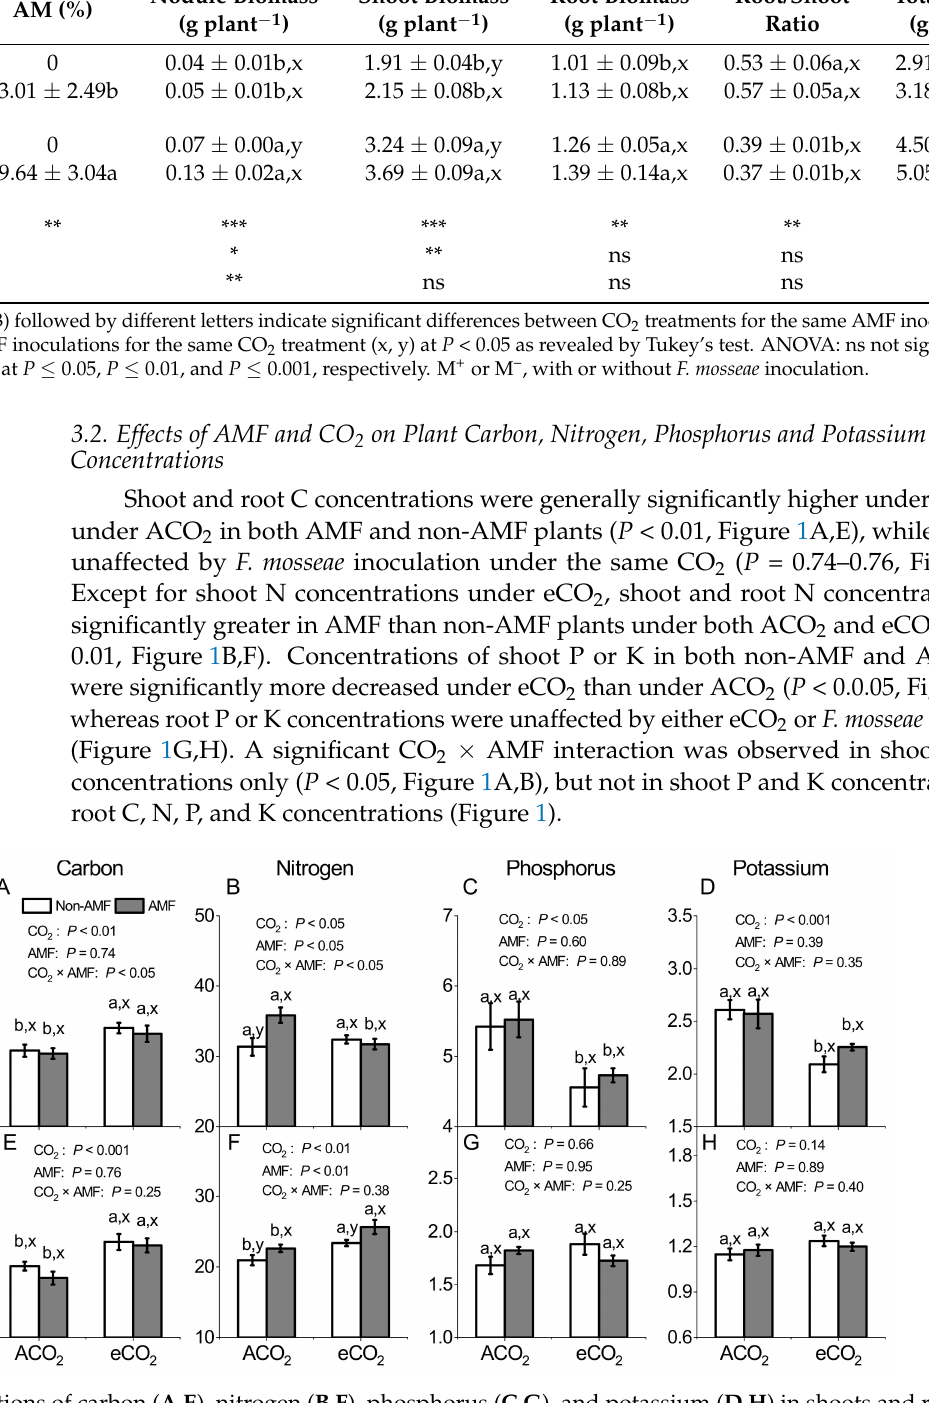
Figure 1. Concentrations of carbon ( A , E ), nitrogen ( B , F ), phosphorus ( C , G ), and potassium ( D , H ) in shoots and roots of Funneliformis mosseae inoculated faba beans grown for 12 weeks at ambient CO 2 (ACO 2 ) and elevated CO 2 (eCO 2 ). Data (means ± SE, n = 3) followed by different letters indicate significant differences between CO 2 treatments for the same AMF inoculation (a, b) and between AMF inoculations for the same CO 2 treatment (x, y) at P < 0.05 as revealed by Tukey’s test. Statistical comparisons (two-way ANOVA) between AMF or CO 2 treatments as well as their interaction (AMF × CO 2 ) are presented for each